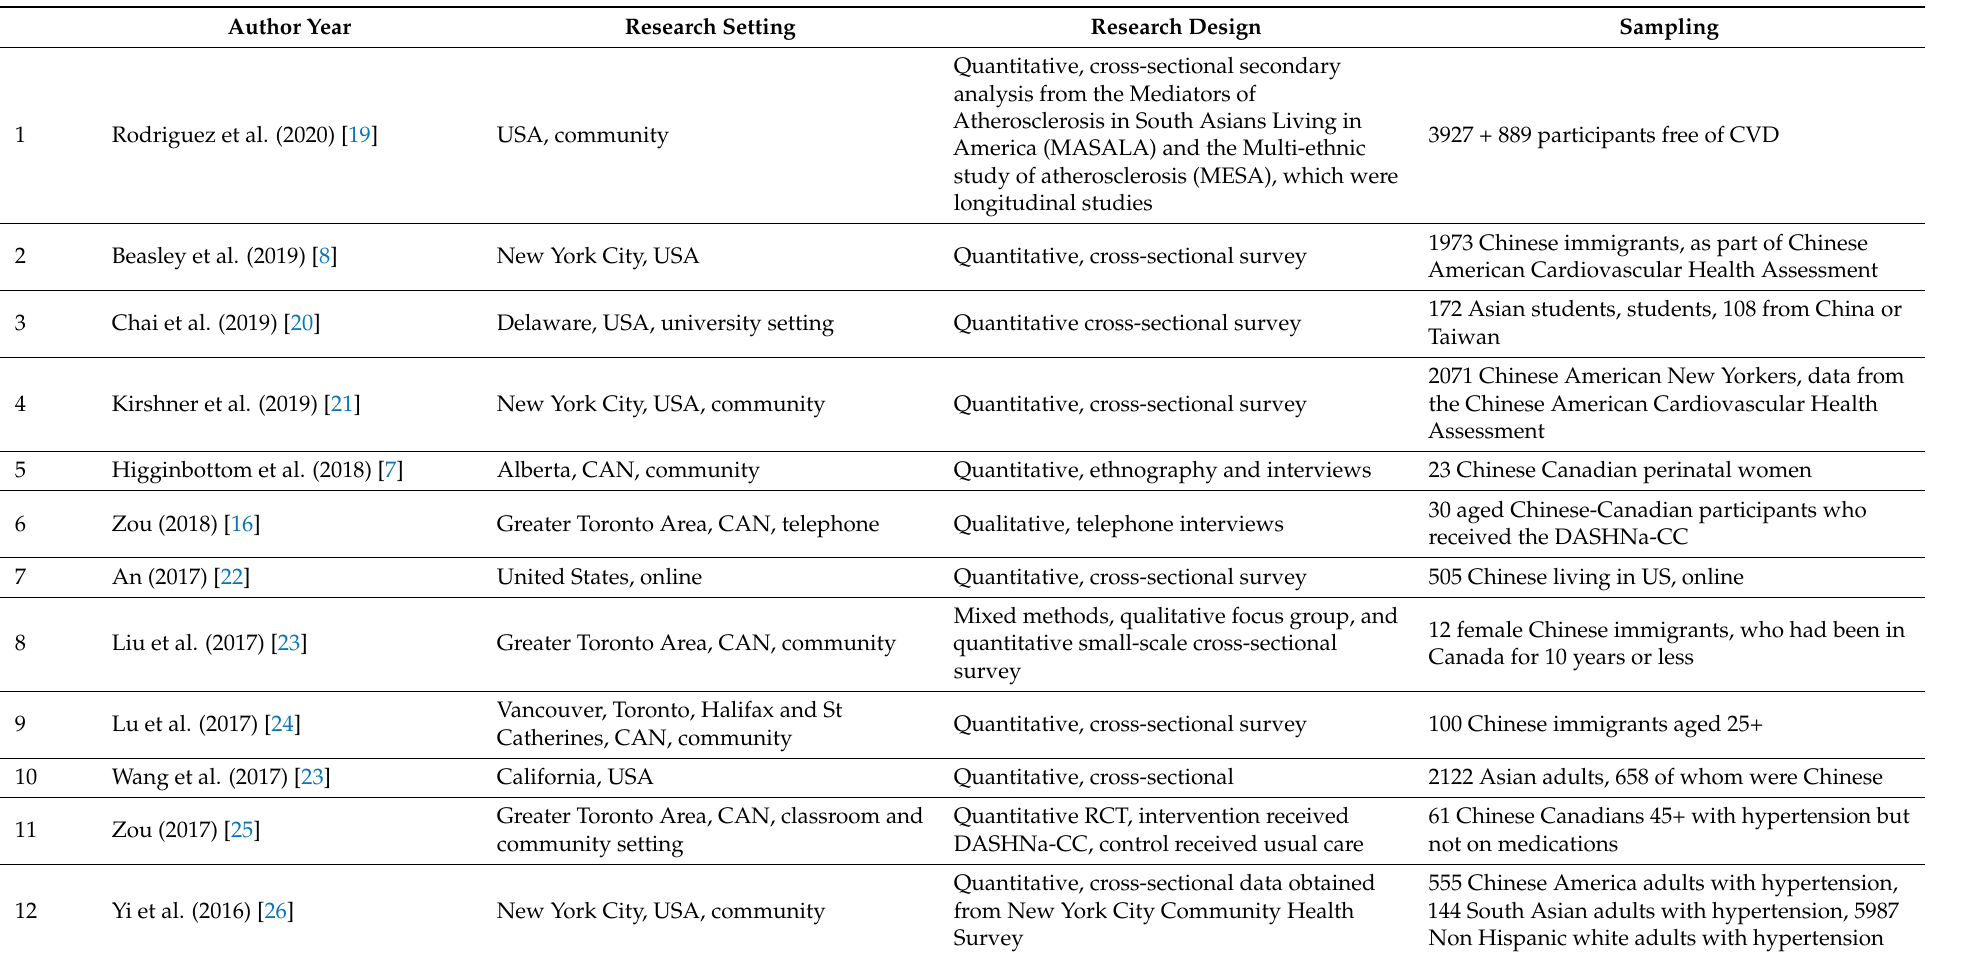
Table 1. Characteristics of included